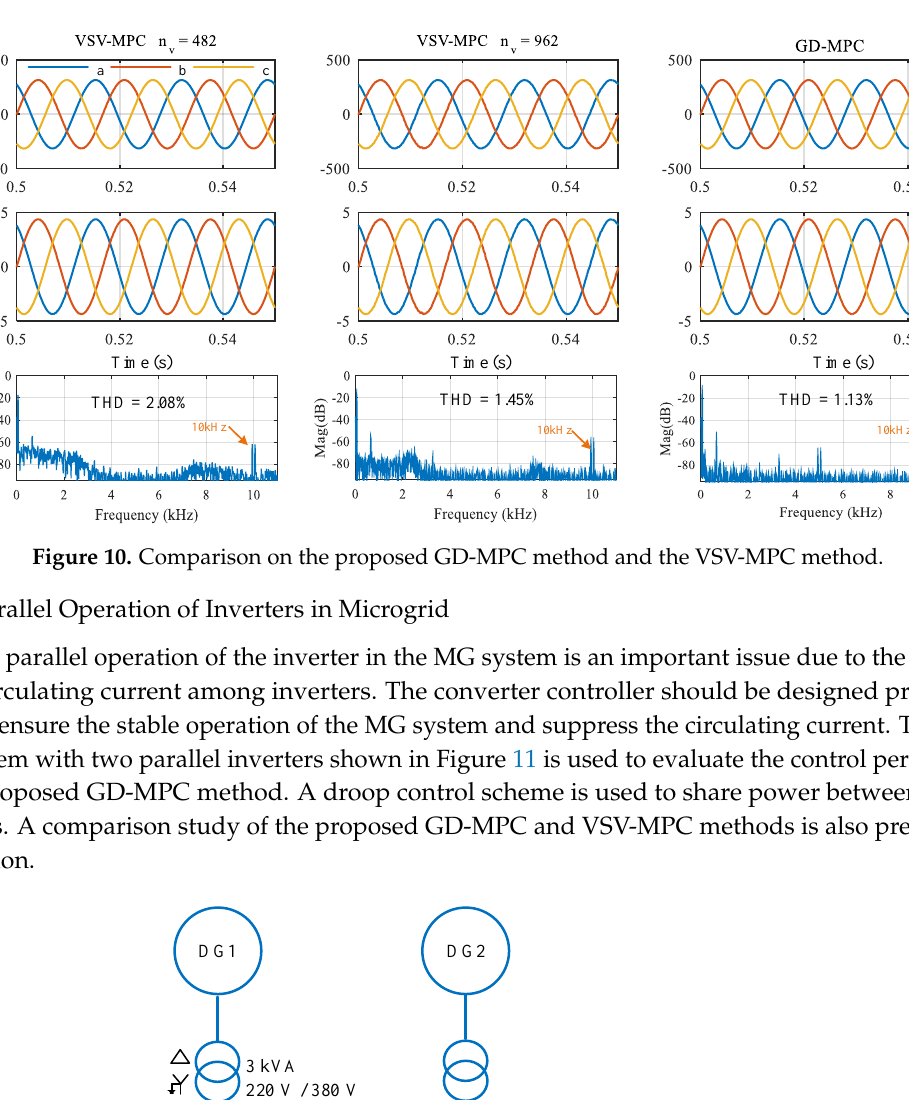
Figure 9. Computation time of the proposed gradient descent model predictive control (GD-MPC), virtual state vector model predictive control (VSV-MPC), and conventional model predictive control (MPC). Figure 9b shows the comparison of the computation time of the proposed GD-MPC and the conventional MPC method, and which of the two is the computationally efficient MPC method. The computation time of the proposed GD-MPC method is dependent on the learning rate value (  ). It can be seen that the computation time of the proposed method is reduced with the increase of the learning rate. The conventional MPC method always evaluates eight possibilities of the cost function to find the optimal vector, whereas the proposed GD-MPC method could find the optimal vector with a few iterations. Thus, the computation time of the proposed method is smaller than that of the conventional MPC when the value of the learning rate is larger than five, as shown in Figure 9b. The control performances of the proposed GD-MPC method, the VSV-MPC method, and conventional MPC method are shown in Figure 10. It can be seen that the performance of the conventional MPC method is not good, because only eight vectors are used to control the voltage. Thus, a lot of computation time is not required, but the performance is not good. Also, the performance of the VSV-MPC method is improved by increasing the number of virtual state vectors. With the number of virtual state vectors equal to 962 in the case of the VSV-MPC method, the output